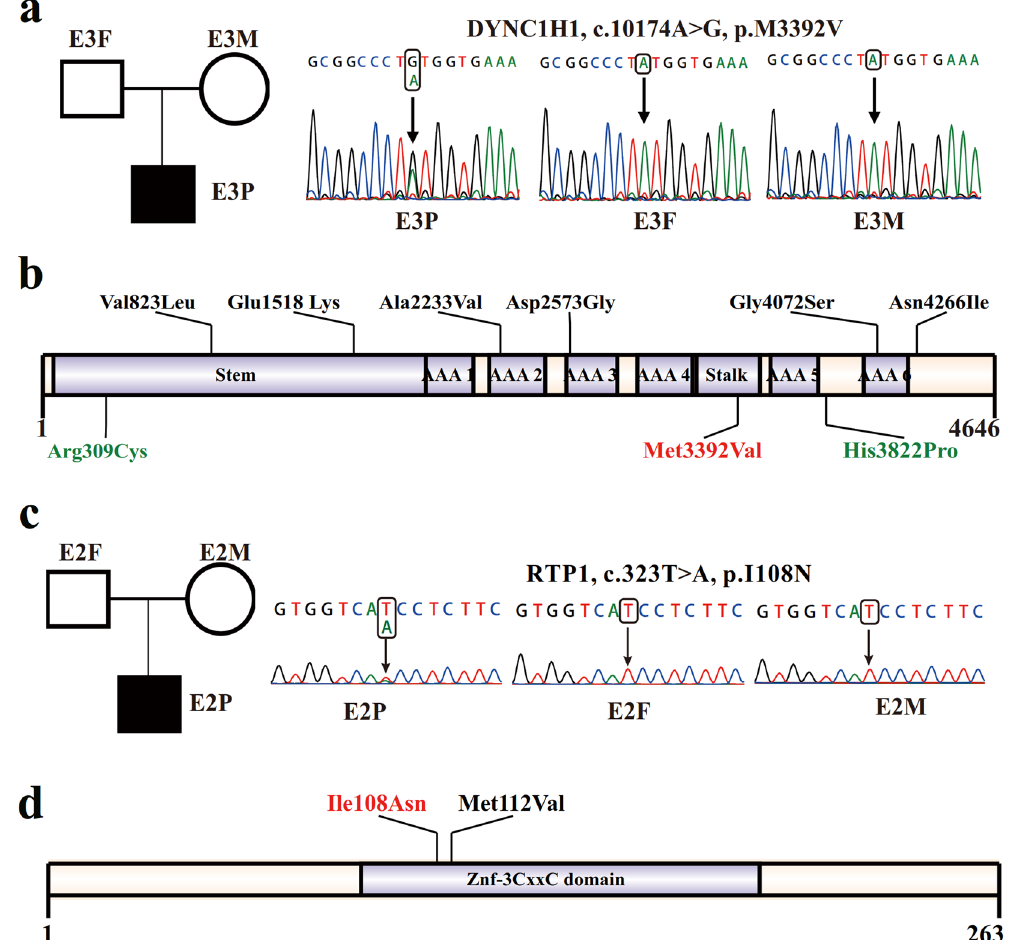
Figure 1. De novo mutations identified in DYNC1H1 and RTP1 . ( a ) The de novo mutation of DYNC1H1 was confirmed in trio E3 using Sanger sequencing. ( b ) Schematic representation of the DYNC1H1 protein and de novo mutations of DYNC1H1 identified in EE, ASD and ID. Protein changes are shown in black for ASD, green for ID and red for EE. ( c ) The de novo mutation of RTP1 was confirmed in trio E2 using Sanger sequencing. ( d ) Schematic representation of the RTP1 protein and de novo mutations of RTP1 identified in EE. Protein change identified in the present study is shown in red, and those identified in the previous study are shown in